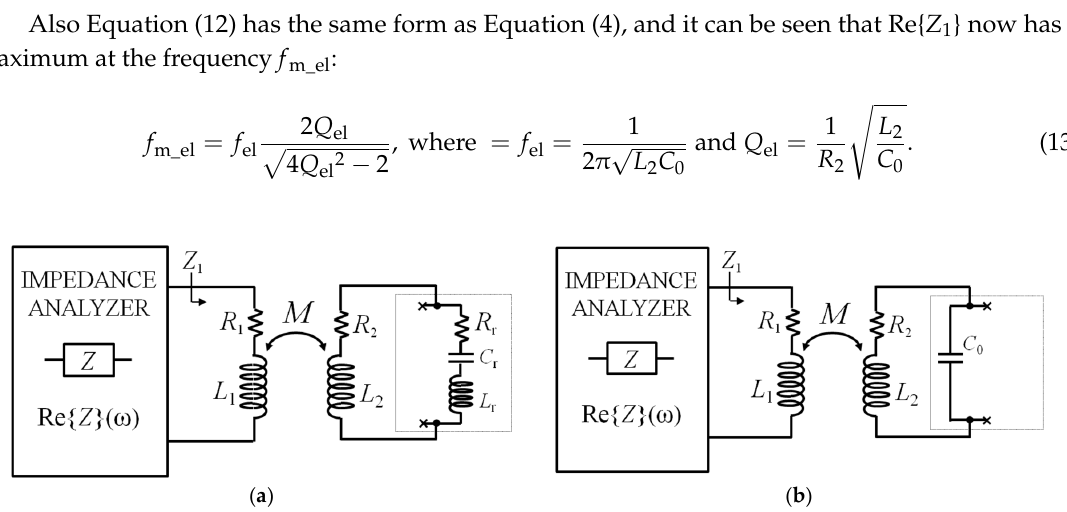
Figure 7. ( a ) Block diagram of the interrogation system with equivalent circuit of electromechanical piezoelectric resonator around f r ; ( b ) block diagram of the interrogation system with equivalent circuit of electromechanical piezoelectric resonator for f >> f r .